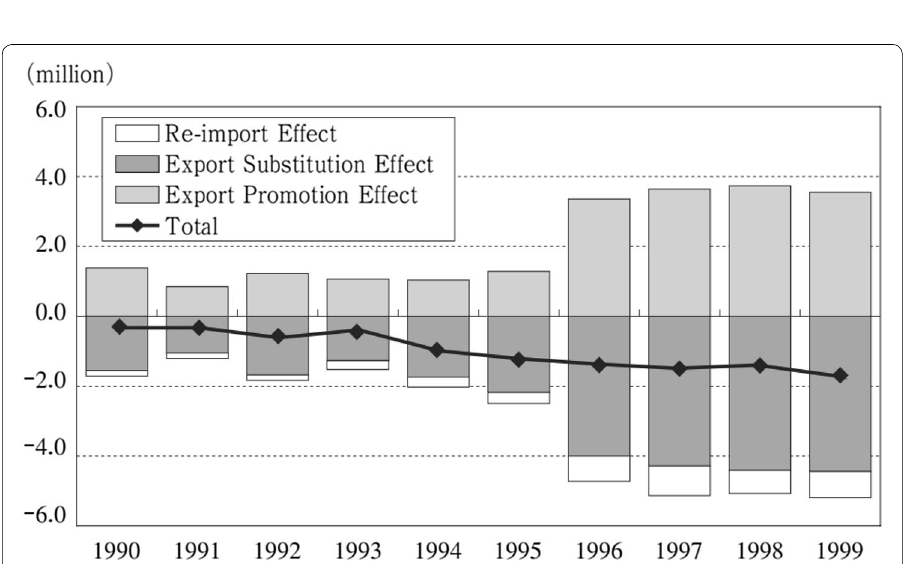
Fig. 5 Impact of outward FDI on the employment of Japan (1990–1999). Source : Fujikawa and